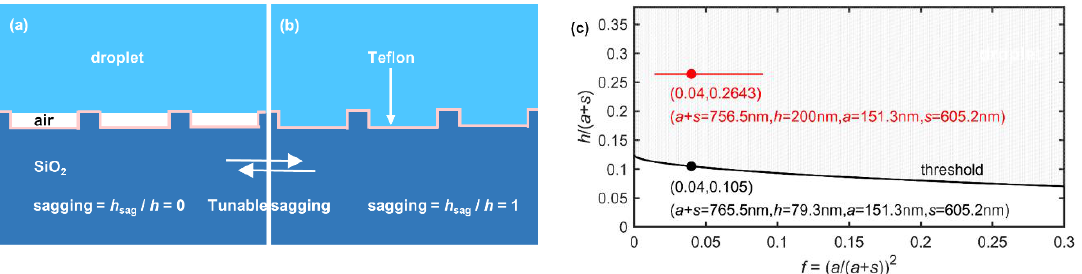
Figure 2. Reversible sagging effect ( a ) sagging = h sag /h = 0, ( b ) sagging = h sag /h = 1; ( c ) constraints on pillar size for a surface with θ Y = 110°. Red line represents the range of pillar sizes designed for waveguide Bragg grating. Note that this range is above the threshold, which satisfies the requirement for superhydrophobicity.